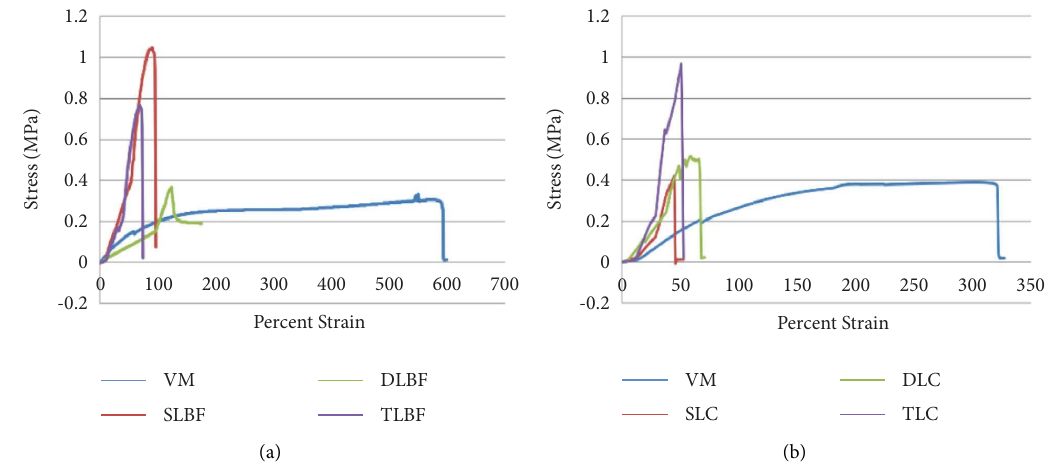
Figure 11: Comparative study of tensile properties (a) with diferent layers of silk fbre (b) with diferent layer of silk cloth.